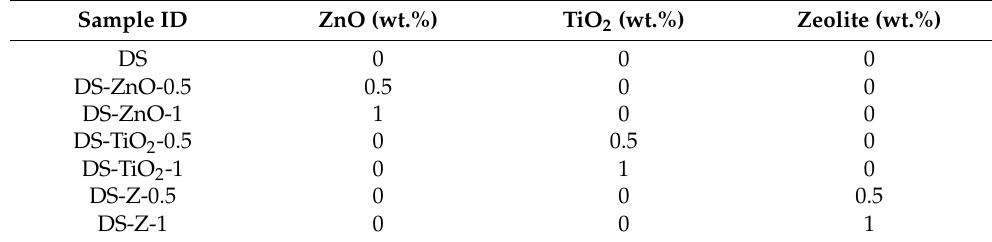
Table 1. Composition of the decontamination